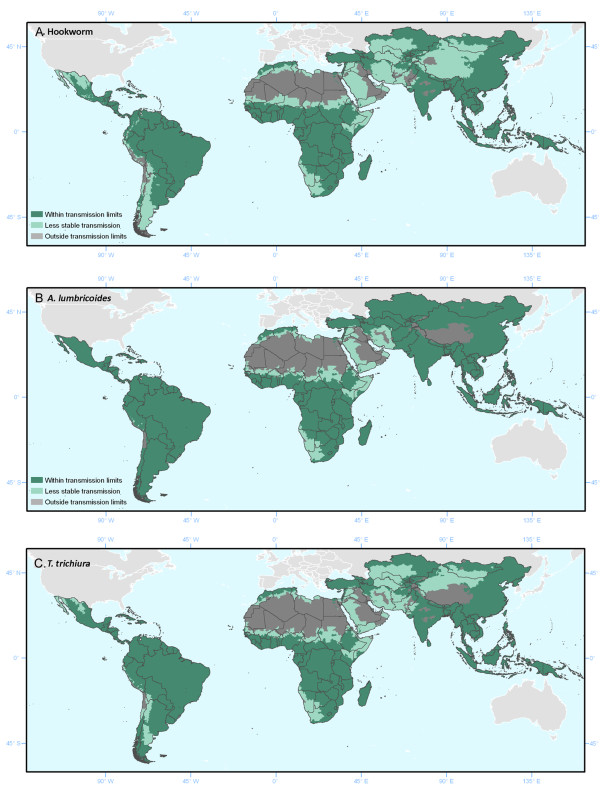
Climatic suitability for (A) hookworm, (B)A. lumbricoidesand (C)T. trichiuratransmission defined by land surface temperature and aridity. Areas were defined as stable (dark green), unstable (light green, where infection prevalence <2%), or no risk (light grey). Exclusion masks were developed in a step-wise fashion on the basis of species and region specific climatic thresholds.